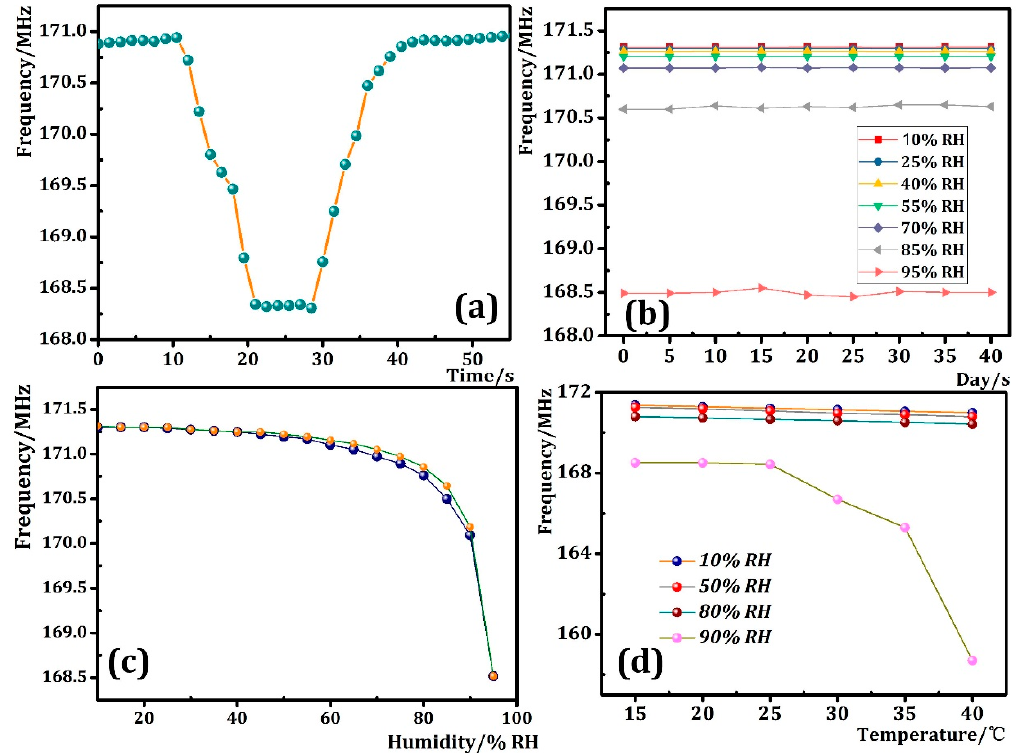
Figure 8. ( a ) The response and recovery, ( b ) long-term stability and ( c ) hysteresis results of as-prepared humidity sensor; ( d ) frequency-temperature curve at different humidity.